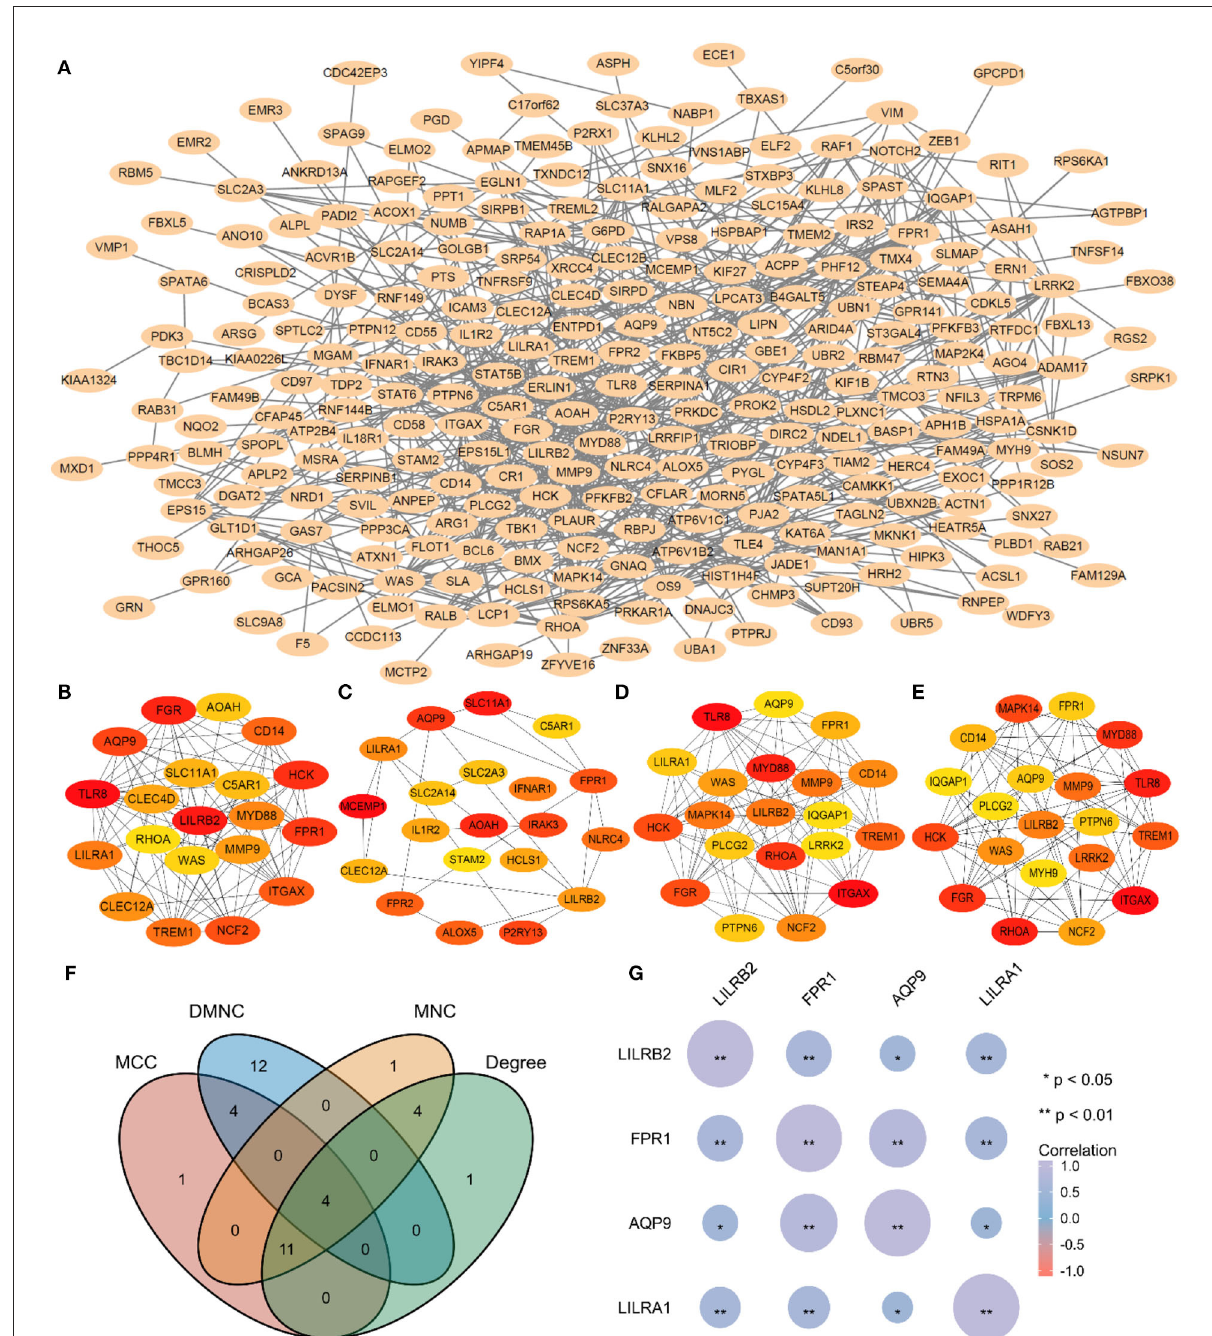
FIGURE6 Hub genes identification. (A) Construction of PPI using 332 genes. (B) The Top 20 gene of MNC algorithm in PPI. (C) The Top 20 genes of DMNC algorithm in PPI. (D) The Top 20 genes of MCC algorithm in PPI. (E) The Top 20 genes of Degree algorithm in PPI. (F) The Venn plot of the intersection between four algorithms. (G) Pearson’s correlation coefficient and correlation significance p -value among four hub genes of AUVP. MNC, maximum neighborhood component; DMNC, density of maximum neighborhood component; MCC, maximal clique